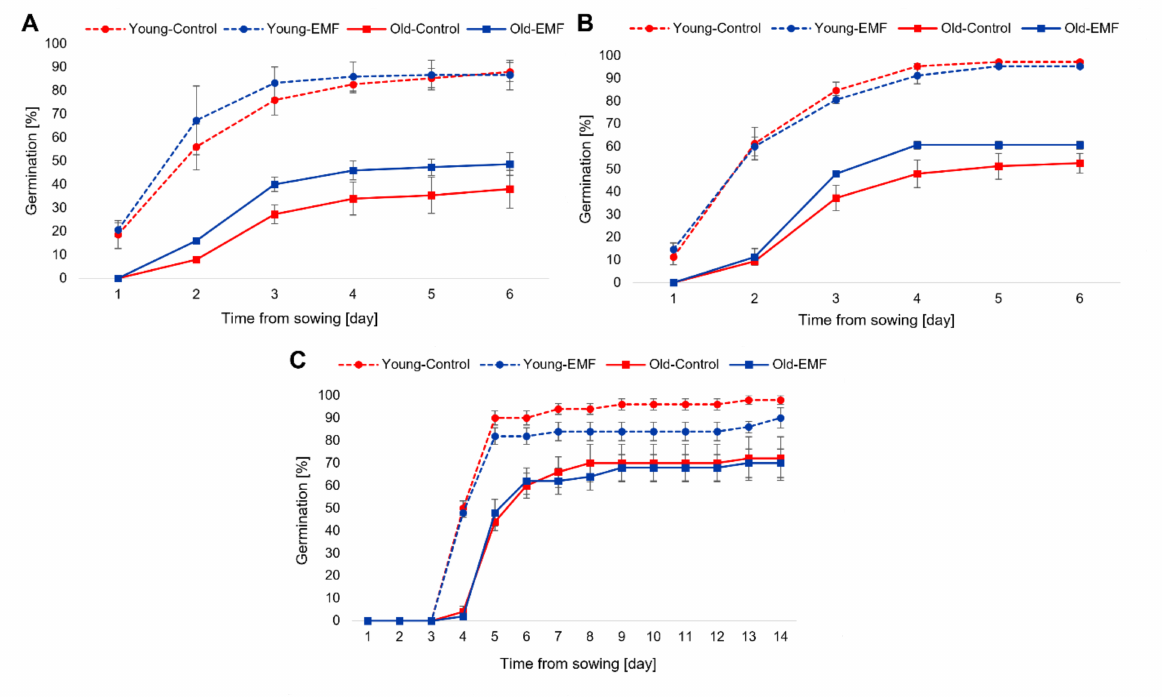
Figure 2. Germination kinetics of young and old field bean seeds sown in Petri dishes under long-day conditions ( A ), in Petri dishes in continuous darkness ( B ), and in pots under long-day conditions ( C ). The points represent mean values ± standard error (SE). Petri dish and pot tests were replicated three times ( n = 50 per replicate) and five times ( n = 10 per replicate), respectively. The levels of significant differences ( p < 0.05; p < 0.01) between particular experimental groups are indicated in the text in the Results